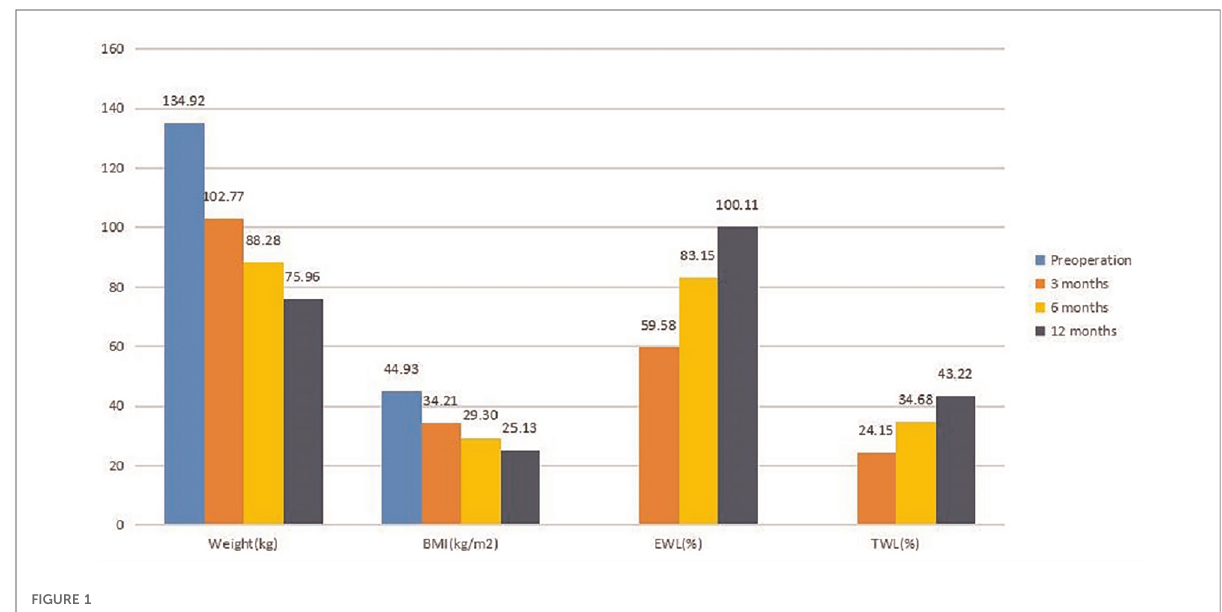
FIGURE 1 The changes of weight, BMI, EWL and TWL after BPD-DS.